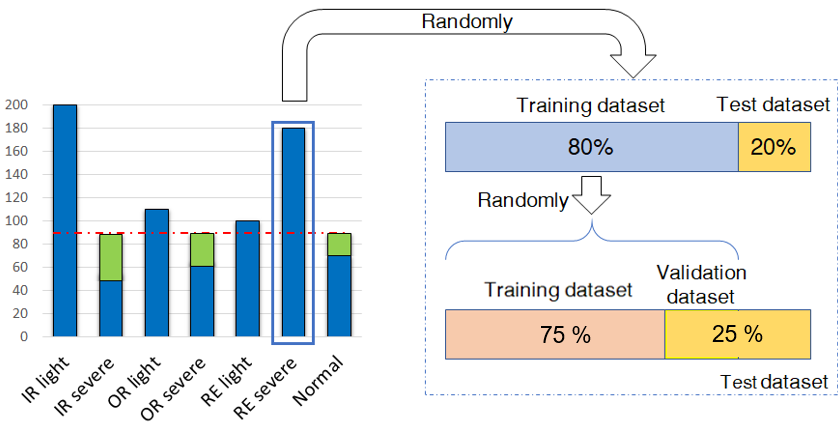
Figure 1. Data organization: 80% of data were used to train 1D-CNN and 20% were used to test it. From training data, 75% were used to train the network, while 25% were used to validate it.